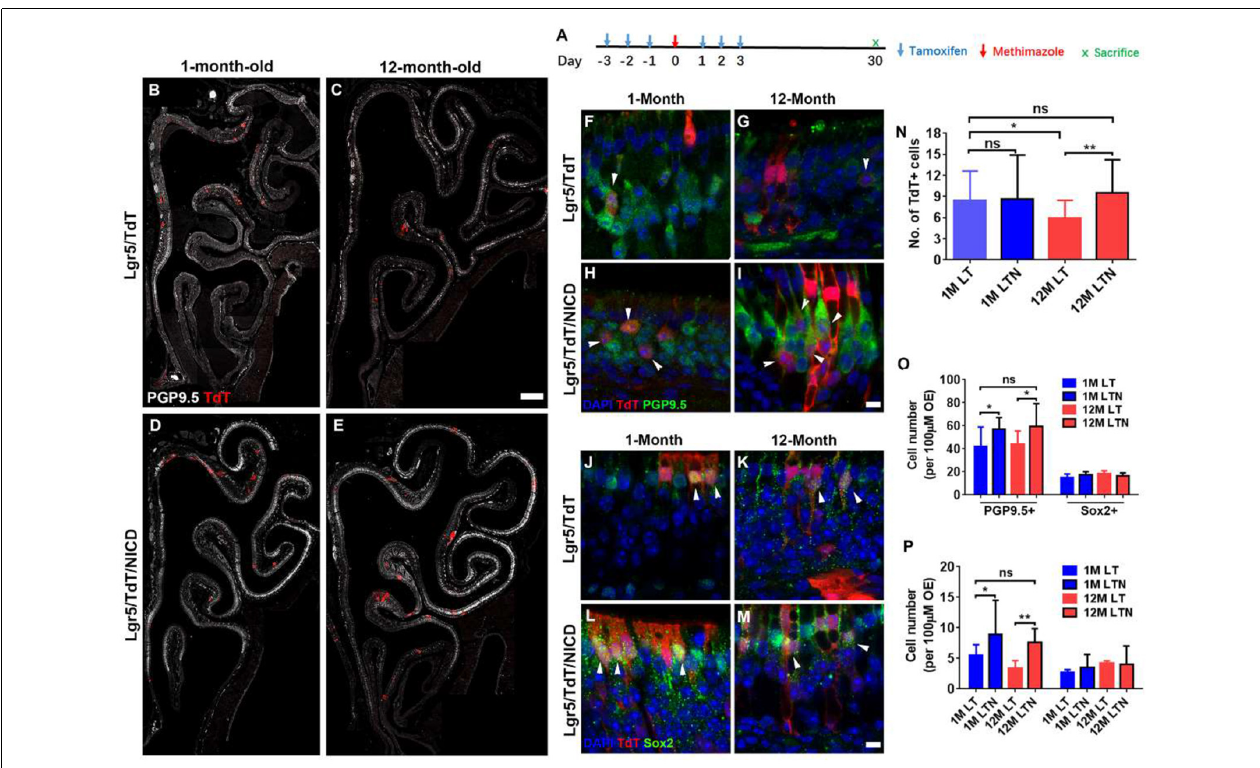
FIGURE 6 | Notch activation recovered neuronal regeneration of Lgr5+ cells in aged OE. (A) Scheme showing the tamoxifen and methimazole administration in Lgr5/TdT (LT) and Lgr5/TdT/NICD (LTN) mice. (B–E) Images showing PGP9.5+ and TdT+ cells in the OE from LT and LTN mice at Day 30 postinjury. (F–I) Immunostaining against PGP9.5 in injured OE from LT and LNT mice at 1- and 12-month old. The TdT+/PGP9.5+ cells were labeled by arrowheads. (J–M) Confocal images of TdT+/Sox2+ cells (noted by arrowheads) in the OE from LT and LNT mice at Day 30 postinjury. (N) Statistical analysis of TdT+ cell density (cell number per 100 µ m OE) in LT and LTN mice at 1- and 12-month old. Totally, 461, 503, 421, and 588 TdT+ cells were counted in young LT, young LTN, aged LT, and aged LTN mice. (O) Statistical analysis of PGP9.5+ and Sox2+ cell density in the OE from young and aged LT and LNT mice at Day 30 postinjury. 1,256, 1,716, 1,419, and 1,429 PGP9.5+ cells and 224, 311, 329, and 247 Sox2+ cells were counted in young LT, young LTN, aged LT, and aged LTN mice. (P) Statistical analysis of TdT+/PGP9.5+ and TdT+/Sox2+ cell density in the OE. In young LT, young LTN, aged LT, and aged LTN mice, 103, 207, 125, and 172 TdT+/PGP9.5+ cells and 42, 62, 75, and 81 TdT+/Sox2+ cells were counted. The statistical significance was determined by unpaired t -test in (N) and by two-way ANOVA with Sidak’s multiple comparisons test in (O) and (P) . ns, not significant. * p < 0.05, ** p < 0.01.